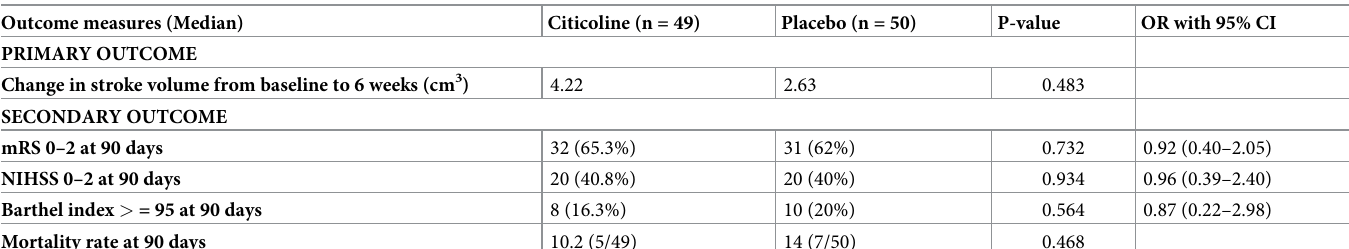
Table 2. Outcome measures (primary and secondary).